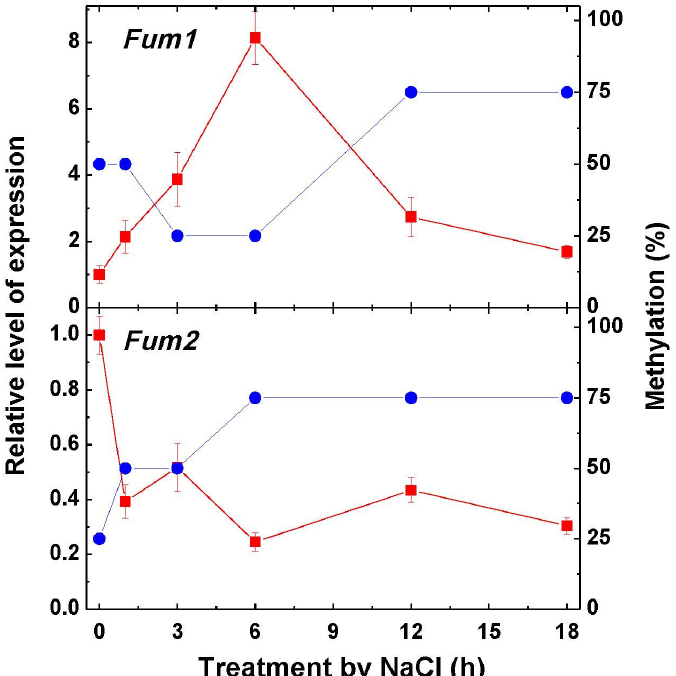
Figure 5. Relative level of transcripts of the genes Fum1 and Fum2 and the rate of methylation of their promoters in maize leaves in the course of incubation of maize seedlings in 150-mM NaCl. The data represent the means of three biological repeats ± SD. The control (untreated) samples of gene expression values did not exhibit statistically significant changes in the variation level.